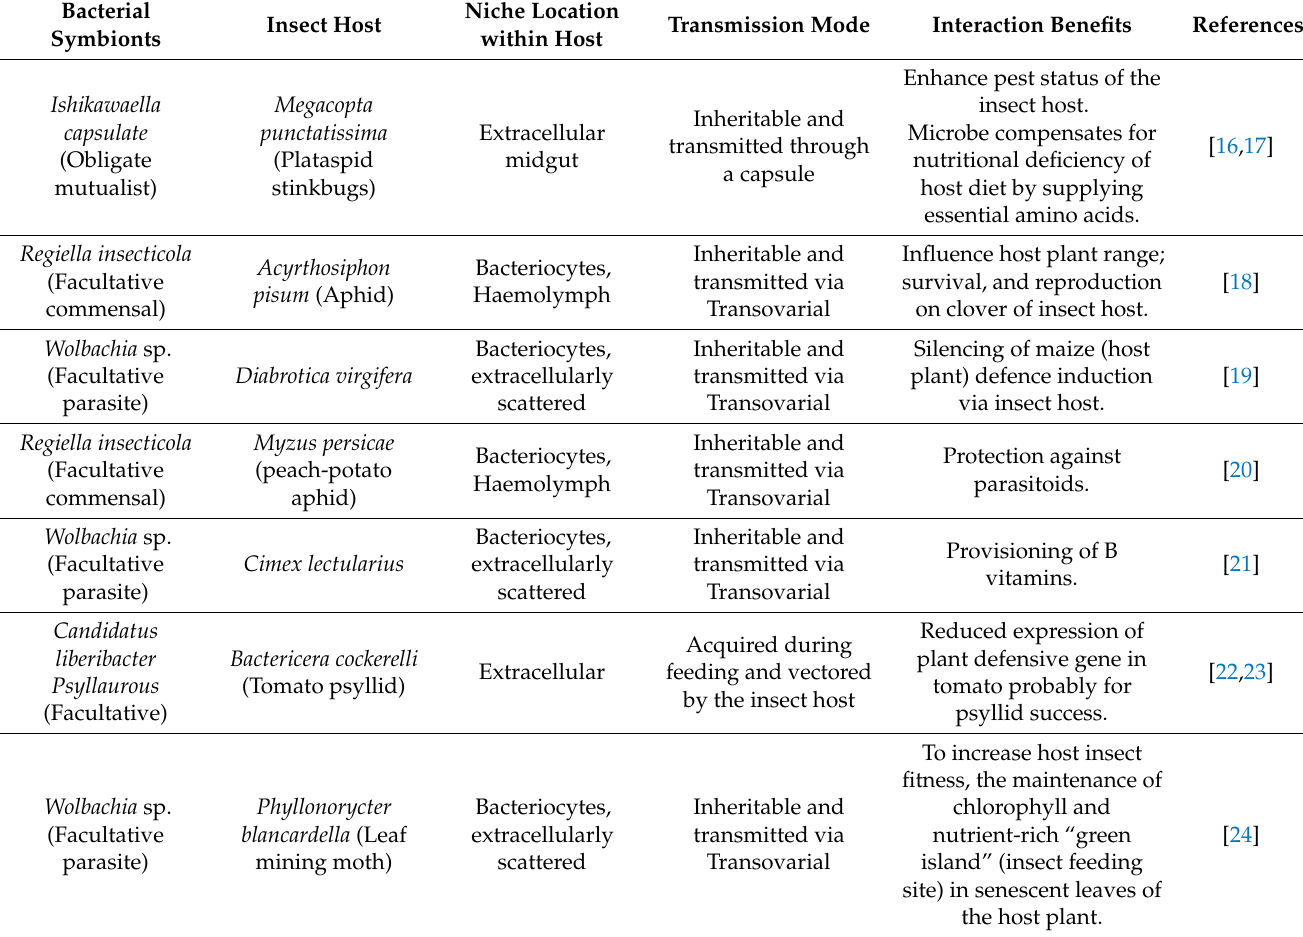
Table 1. A glimpse of symbiotic relationships in